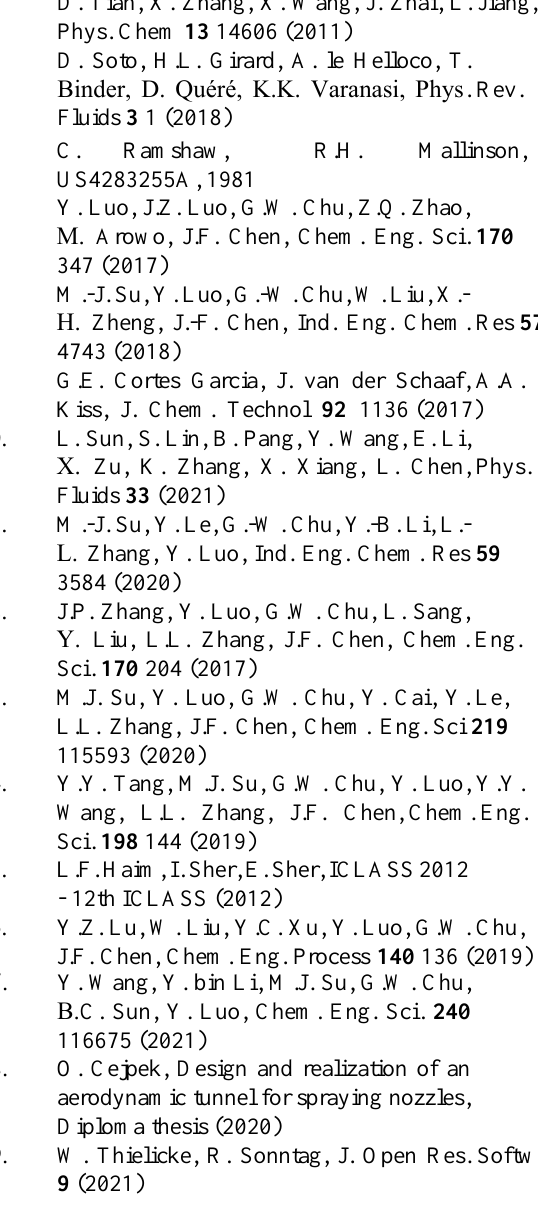
Fig. 10. Images of the liquid dispersion for different input parameters : (a) 𝑊𝑒_𝑑 = 205, the air flow velocity 0 m/s, (b) 𝑊𝑒_𝑑 = 1073, the air flow velocity 3 m/s, (c) 𝑊𝑒_𝑑 = 2218, the air flow velocity 6 m/s